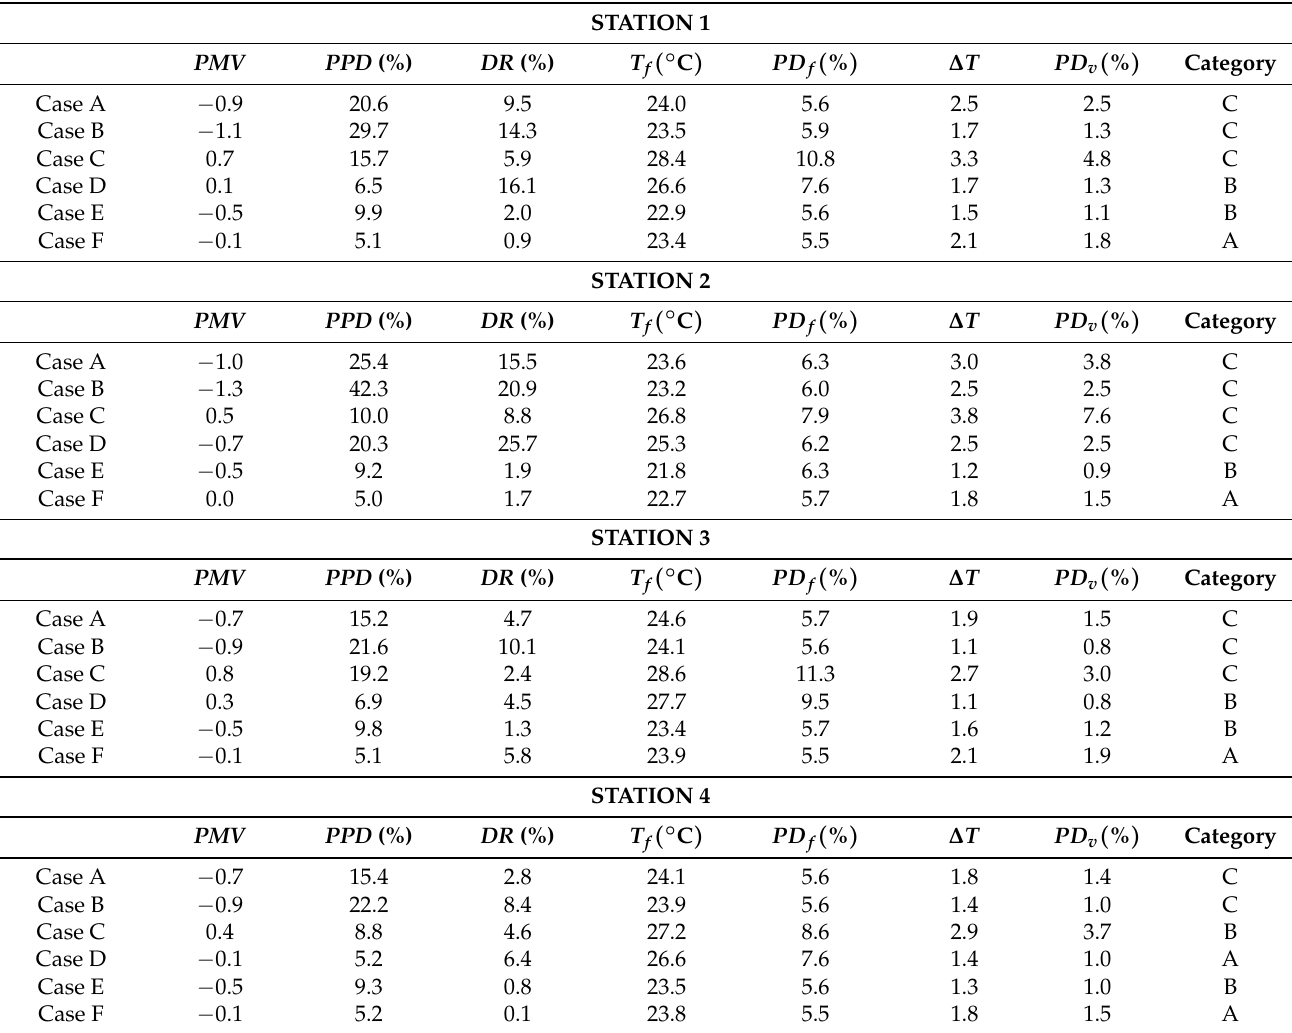
Table 4. PMV , associated PPD , and critical values of local discomfort indices for each case at the four working stations. Categories of the thermal